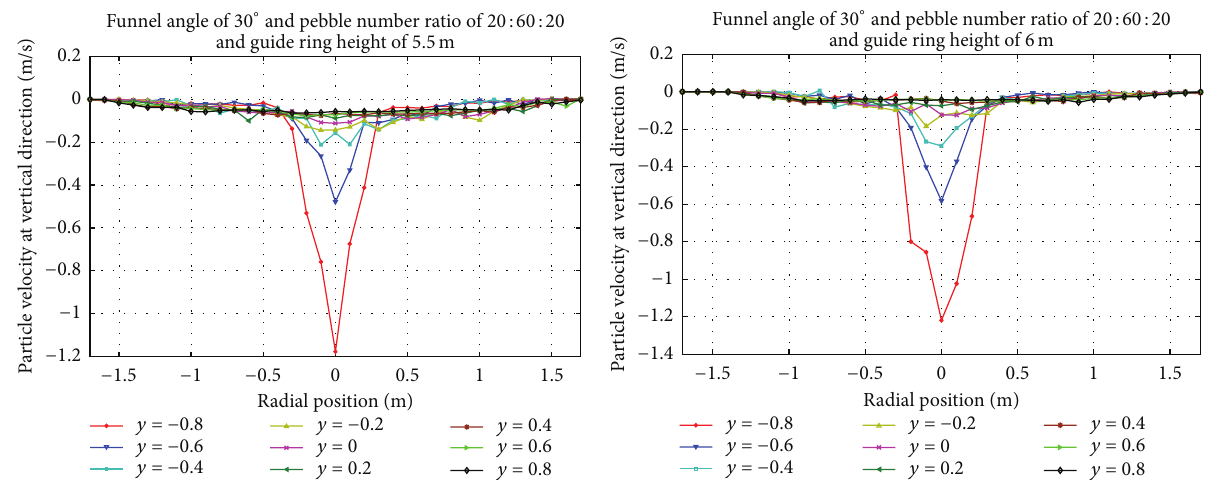
(e) Vertical velocity distribution of pebbles with guide ring of 5.5m at (f) Vertical velocity distribution of pebbles with guide ring of 6m at cone cone region region Figure 9: Vertical velocity distributions of pebbles with different heights of the guide